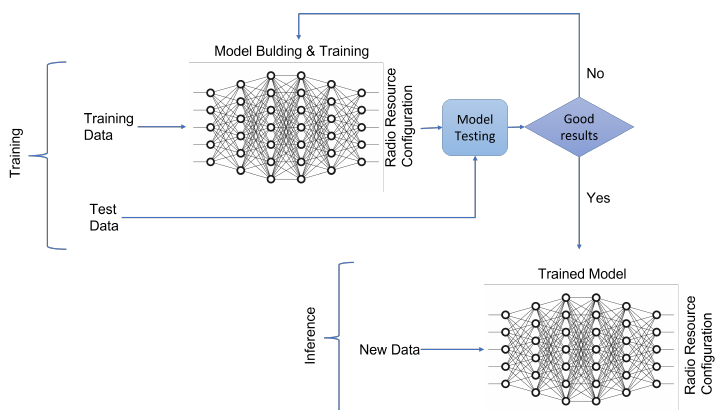
Figure 1. Difference between training and inference of the ML model for